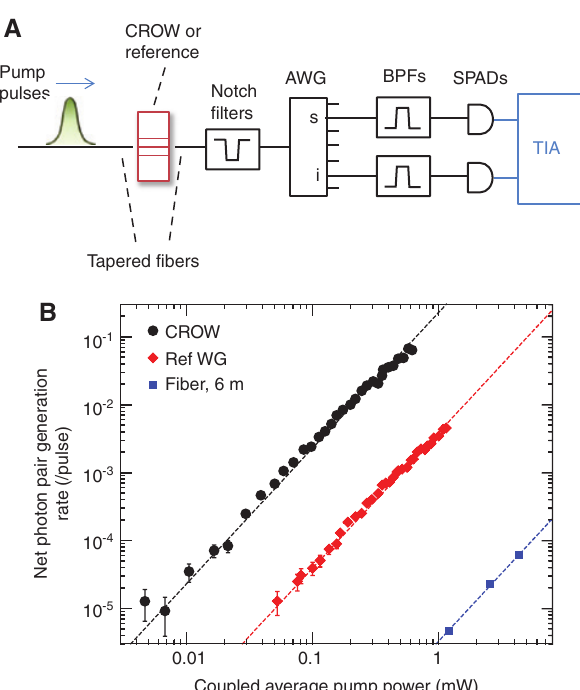
Figure 8: (A) Experimental setup for correlated photon pair genera- tion from the CROW. AWG: arrayed-waveguide grating. (B) Net photon pair generation rate from various waveguides as a function of the in-coupled average pump power. Dashed lines represent fitting results using Eq. (3) [90].